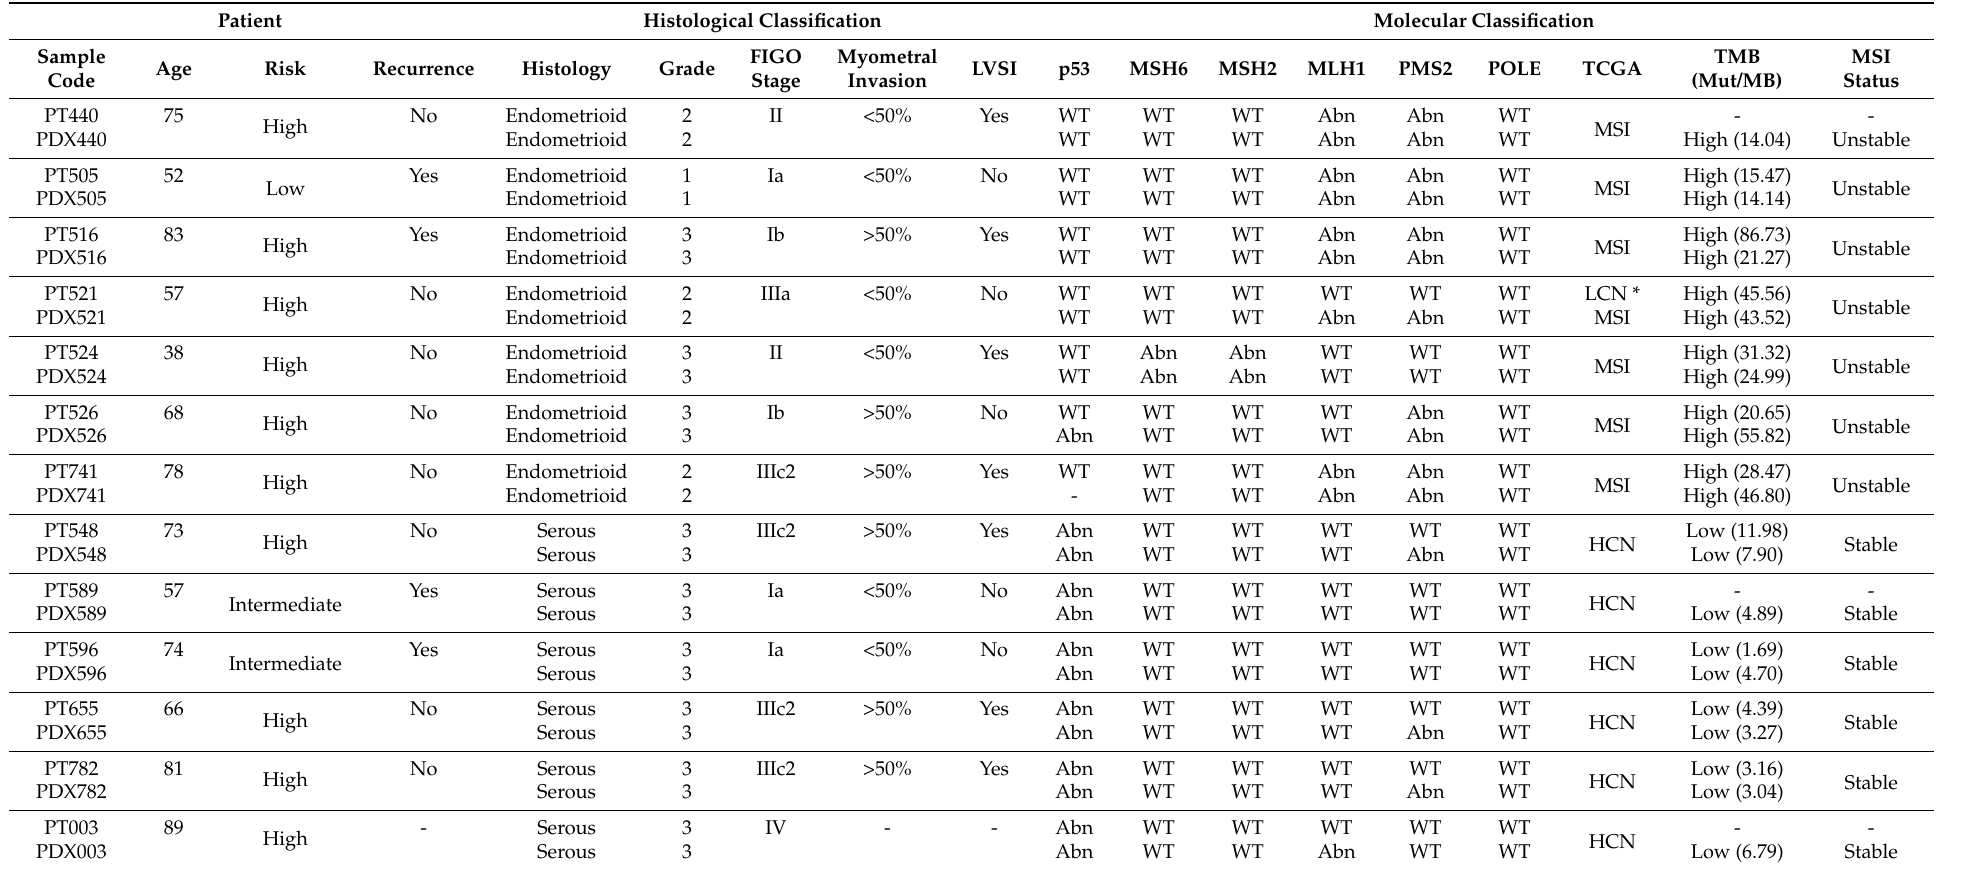
Table 1. Clinicopathological and molecular features of EC patients and their PDX model